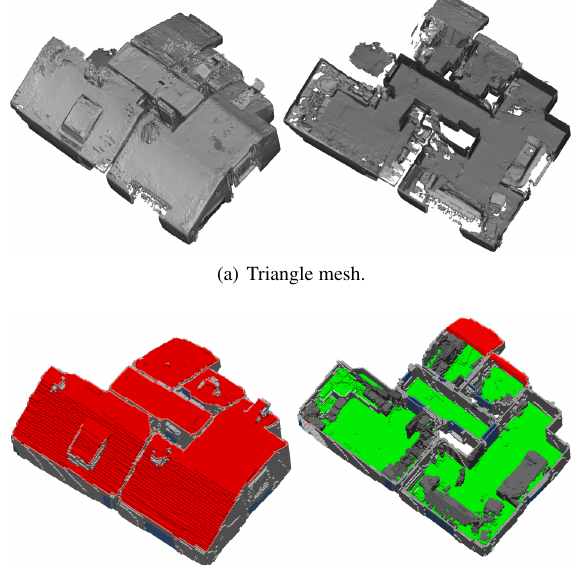
Figure 2. The dataset ’Attic’.